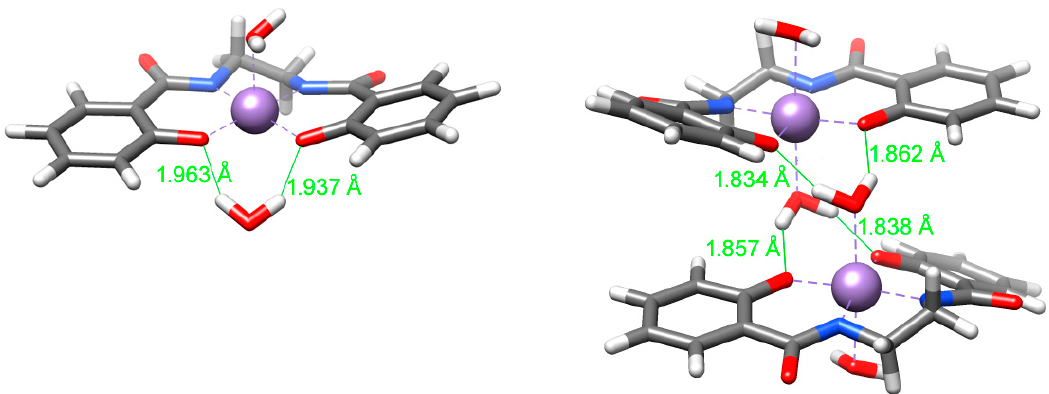
Figure 8. Geometries of the [MnL 1 ] − ·2H 2 O and {[MnL 1 ] − ·2H 2 O} 2 systems obtained with DFT calculations (TPSSh/TZVP). The distances shown correspond to the hydrogen bonds involving water molecules.